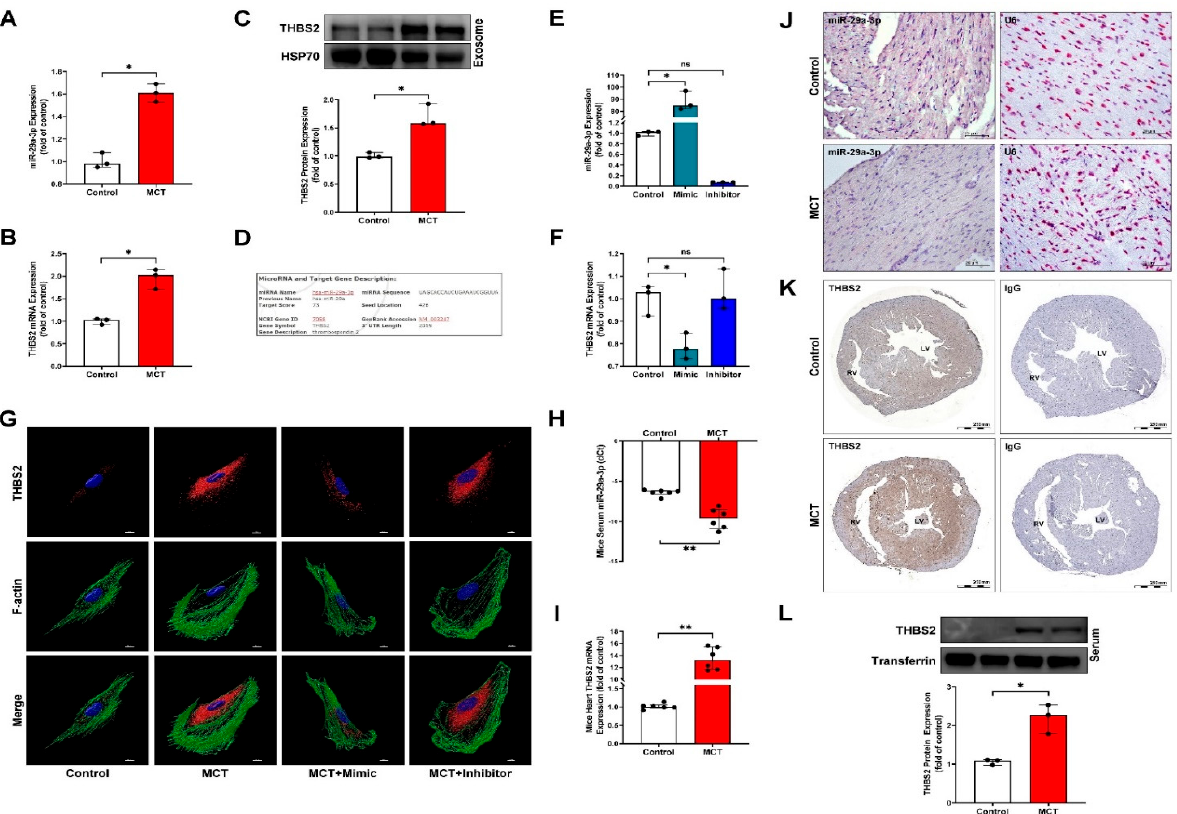
Figure 5. miR-29a-3p regulates THBS2 expression in vitro and in vivo. ( A , B ) MCT-induced expression of miR-29a-3p and exosomal THBS2 mRNA, determined by real-time PCR. ( C ) THBS2 expression in MCT-treated HCM-secreted exosomes determined by western blotting. HSP70 was used as the internal control for exosomal proteins. ( D ) Alignment of the miR-29a-3p with the THBS2 3 ′ -untranslated region, showing the putative binding sites. ( E ) Real-time PCR analysis of miR-29a-3p expression in HCMs after transfection with an miR-29a-3p mimic or inhibitor. Data are representative of three independent experiments ( n = 3), and values are expressed as median and interquartile range. Mann–Whitney U-test was used to compare two independent groups (* p < 0.05). ( F , G ) After transfection, THBS2 expression was analyzed by real-time PCR and immunocytochemical staining. Data are representative of three independent experiments ( n = 3), and values are expressed as median and interquartile range. Kruskal–Wallis test was used to compare two independent groups (* p < 0.05). ( H , I ) MCT-induced expression of miR-29a-3p and THBS2 mRNA, determined by real-time PCR. Mann–Whitney U-test was used to compare two independent groups (** p < 0.01). ( J ) In situ hybridization (ISH) of miR-29a-3p expression (pink color) in myocardial tissues of MCT-induced PAH mice. U6, miRNA internal control. ( K , L ) THBS2 expression in myocardial tissues and circulating serum of MCT-induced PAH mice were examined by immunohistochemistry and western blotting, respectively. Transferrin was used as the internal control. Data are representative of three independent experiments ( n = 3), and values are expressed as median and interquartile range. Mann–Whitney U-test was used to compare two independent groups (* p < 0.05 and ** p <